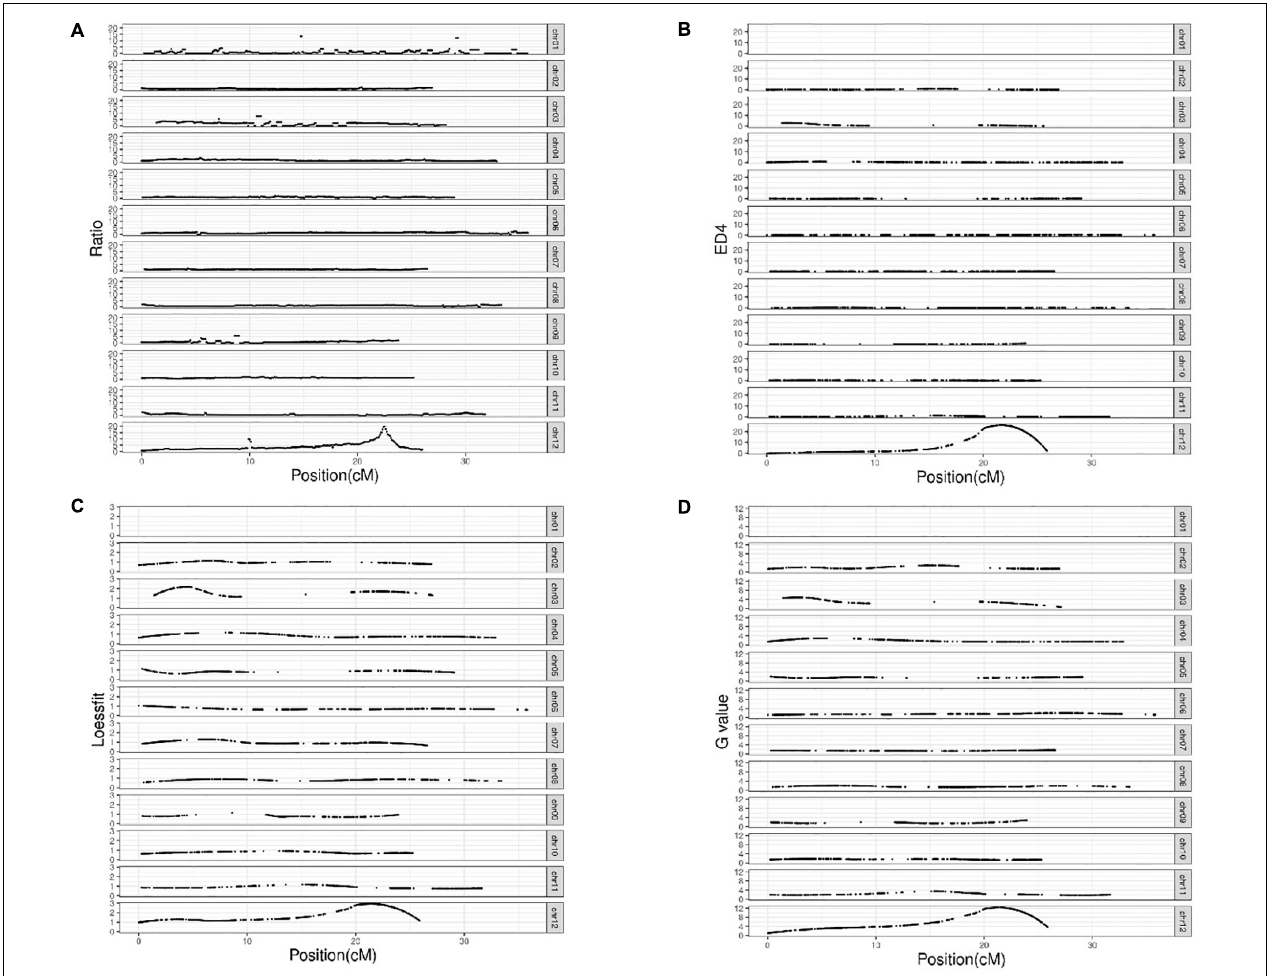
FIGURE 2 | BSA-Seq results. Analysis of the QTL location by (A) the SNP-Ratio method; (B) the ED 4 method; (C) the LOD method; (D) the G-value method.